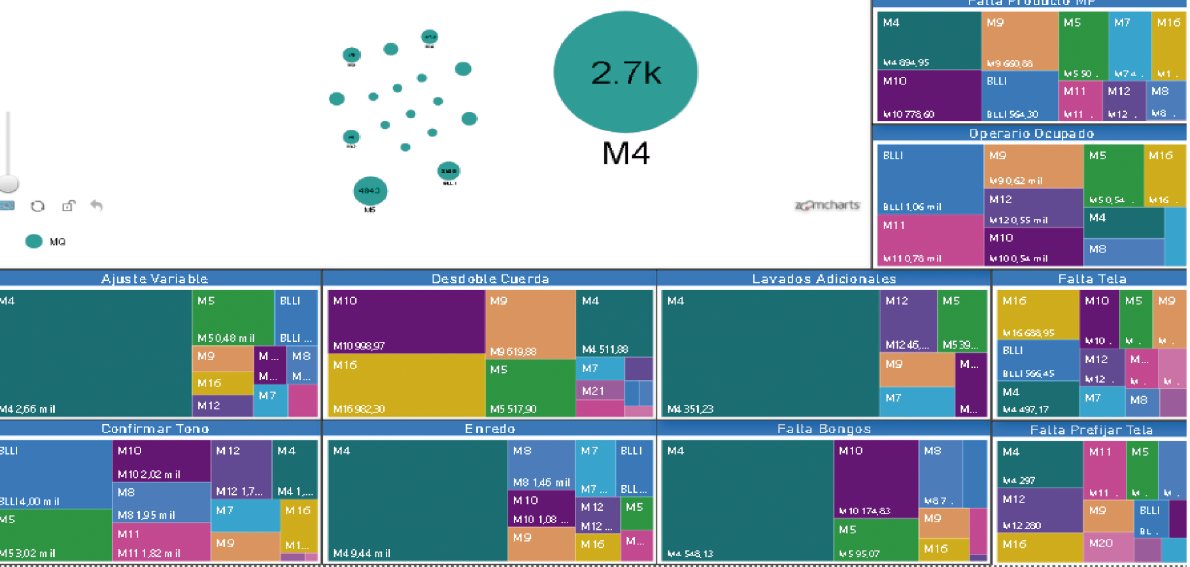
Figure 11. Operational and non-operational